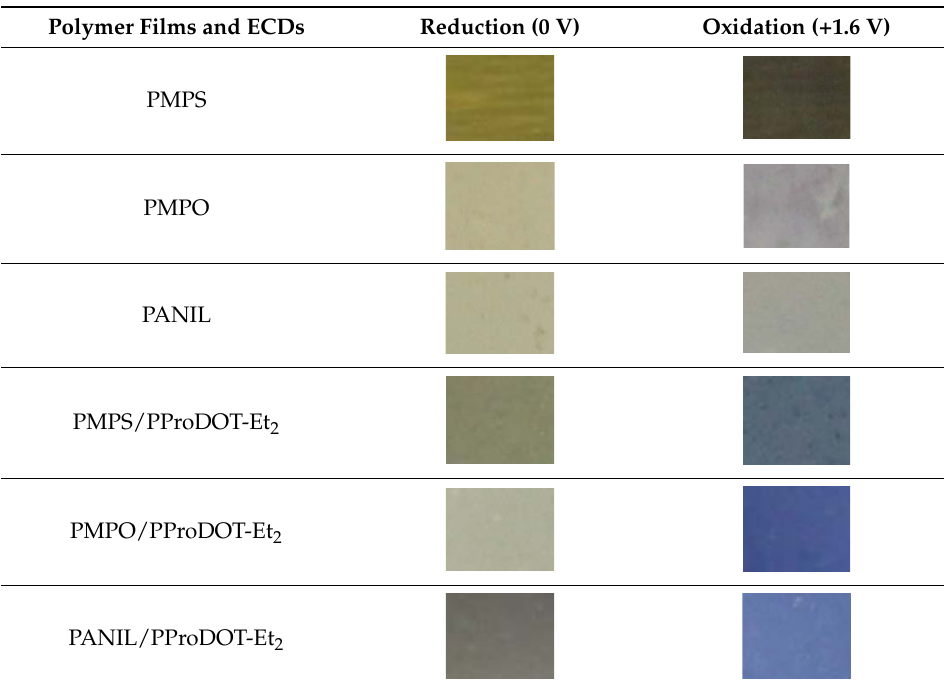
( b ) ( c ) Figure 5. CIE chromaticity diagrams of ( a ) PMPS film in [EPI + ][TFSI − ] solution at − 0.4 V ( ● ) and 1.6 V ( ■ ); ( b ) PMPO film in [EPI + ][TFSI − ] solution at − 0.4 V ( ● ) and 1.6 V ( ■ ); and ( c ) PANIL film in [EPI + ][TFSI − ] solution at − 0.2 V ( ● ) and 1.6 V ( ■ ). The optical band gap ( E g ) of PMPS, PMPO, and PANIL can be calculated according to the Planck equation [34],